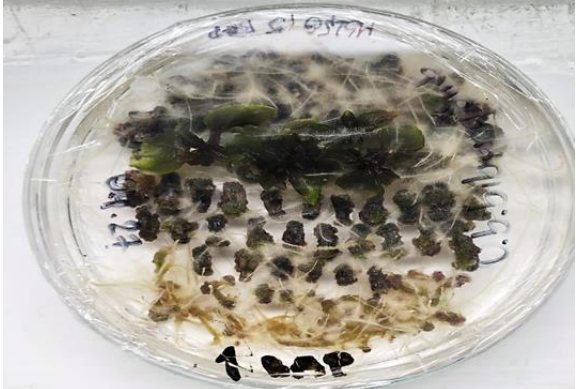
Figure 6. Secondary root regeneration on all types of explants in medium supplemented with 1 BAP Salts Carbohydrides Cytokinin